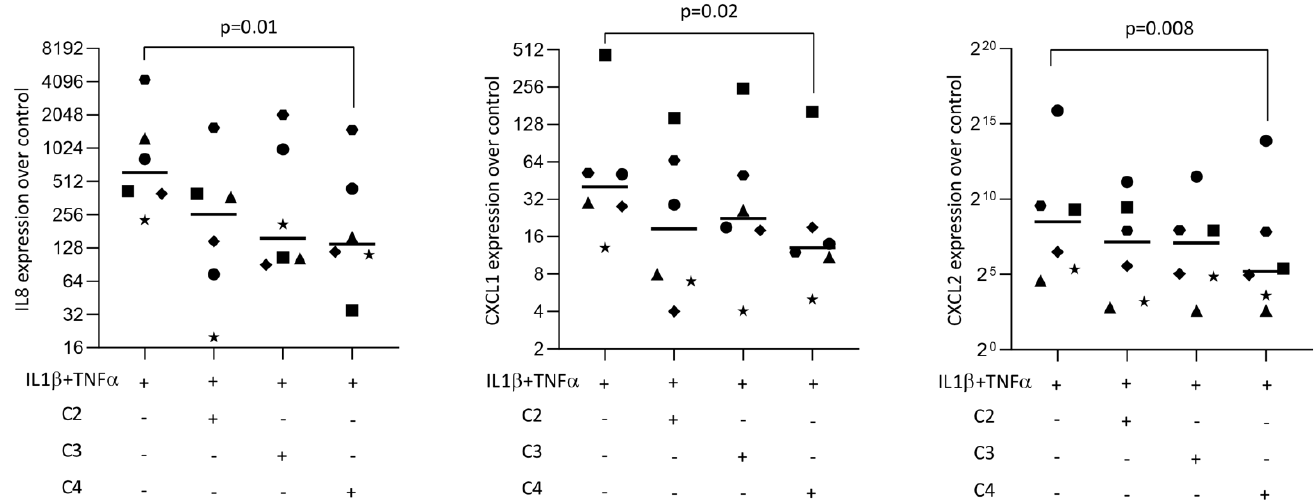
Figure 4. Butyrate, but not acetate or propionate, had significant anti-inflammatory effects in gingival fibroblasts. Cells were exposed to 10 mM of acetate (C2), propionate (C3), and butyrate (C4) in the presence of 10 ng/mL IL1 β and TNF α . Each format shape represents data from individual experiments with the median. Statistical analysis was based on the Friedman test and corrected p values are indicated.